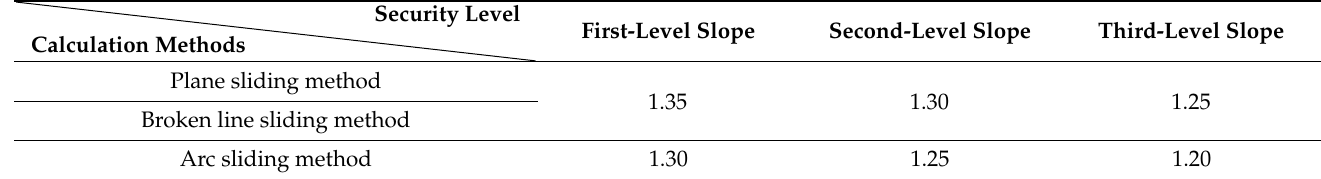
Table 3. Safety factor of landfill